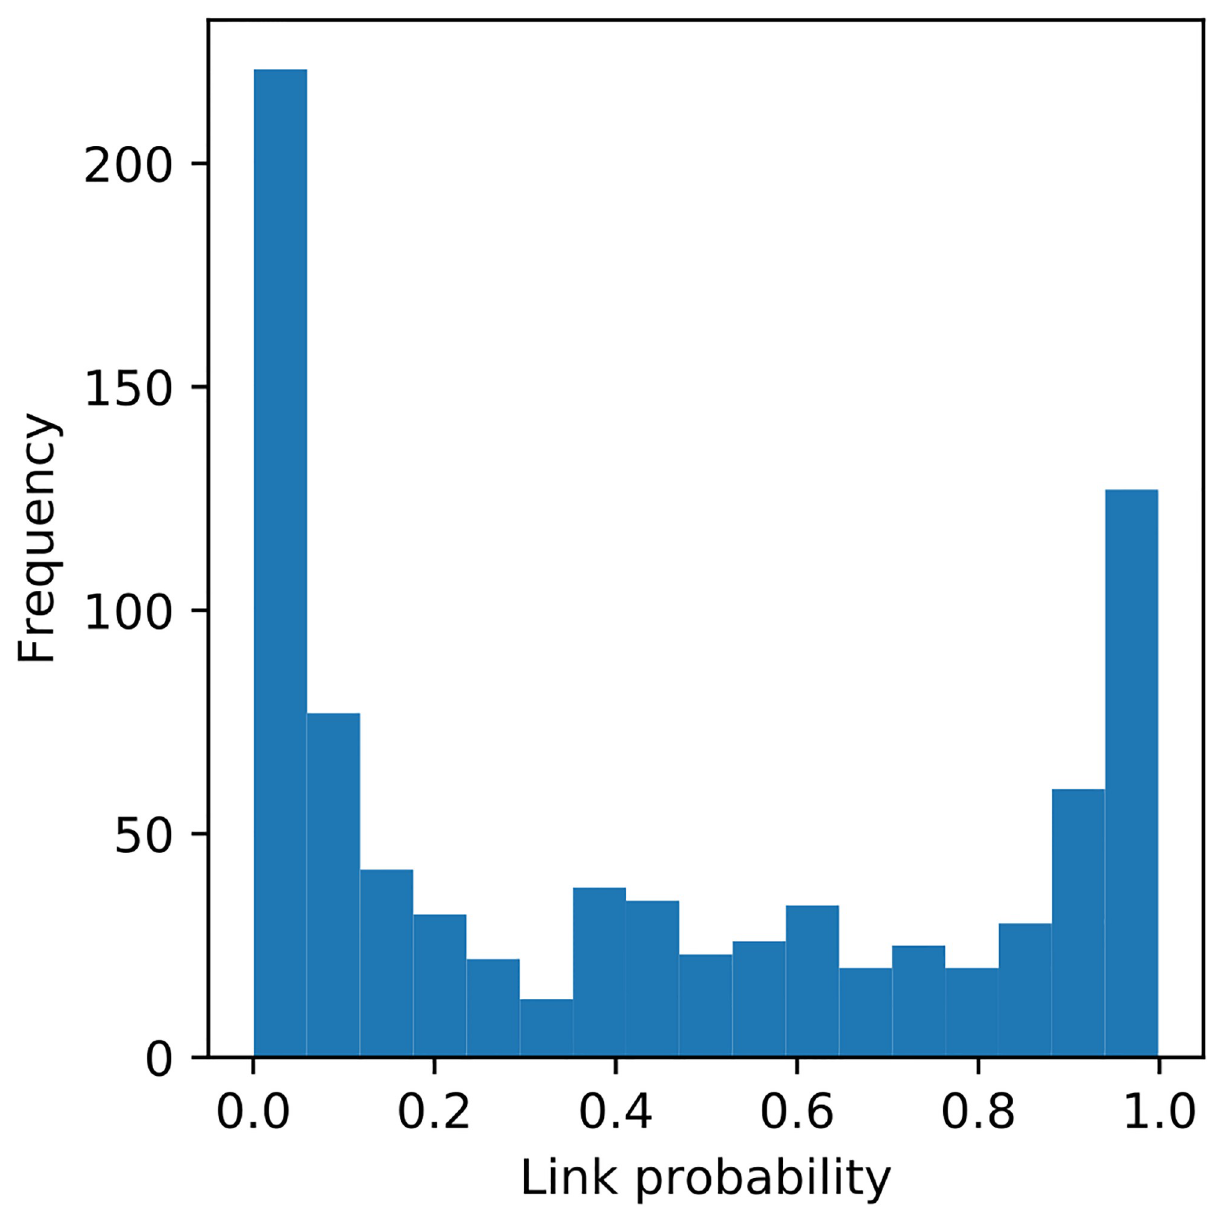
Fig 10. Histogram of the 850 links with estimated probability less than 1 for the data set in Fig 9. The number of links with ^ p ¼ 1 is 7923.